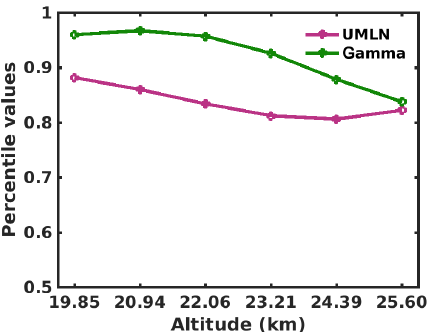
Figure 8. Percentile values computed from the minimized χ 2 of the fits of both the UMLN and gamma distributions to determine the level of confidence for which either distribution is chosen to describe the CARMA model data.